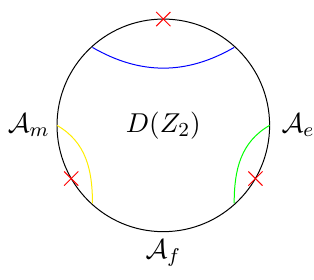
Figure 12 . Three different boundaries separated by three junctions on a disk. The bulk phase is the toric code